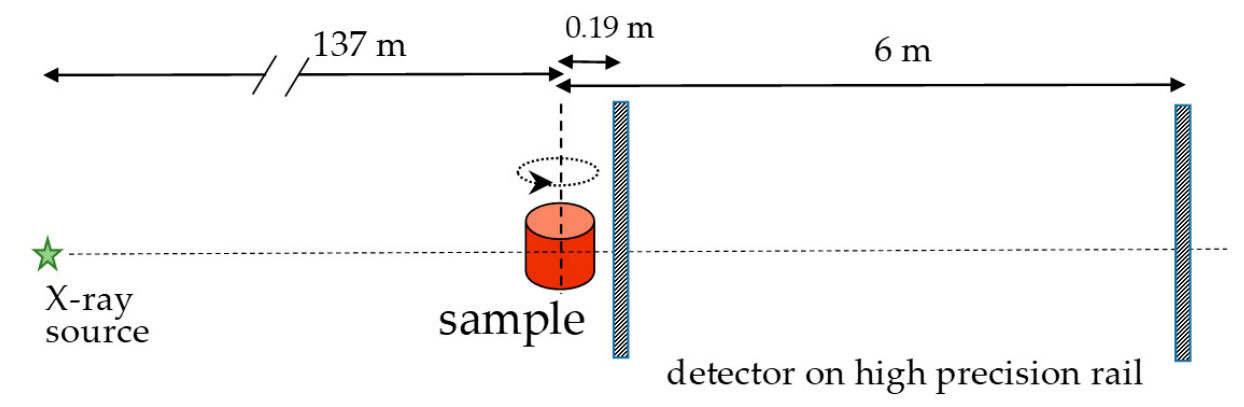
Figure 1. Schematic diagram of the experimental setup for absorption-contrast CT (detector at 0.19 m) and propagation-based PCT (detector at 6 m).